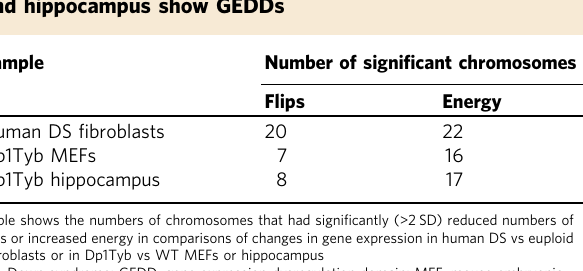
Table 1 Human DS fi broblasts 3 and mouse Dp1Tyb MEFs and hippocampus show GEDDs